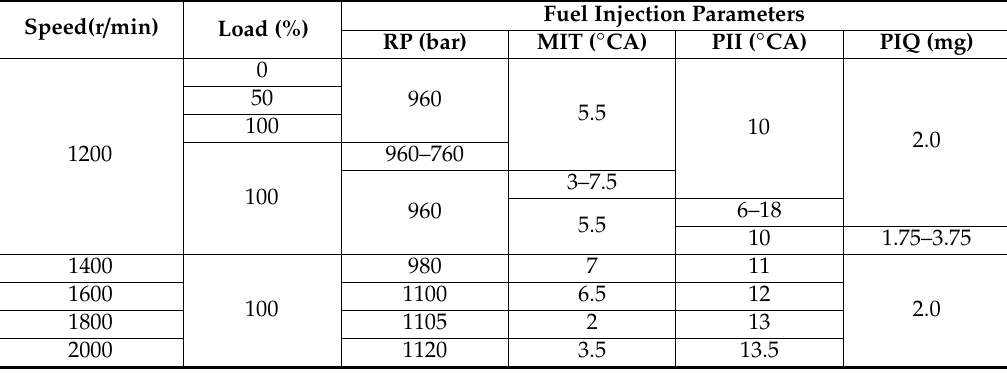
Table 2. Specification of working conditions.